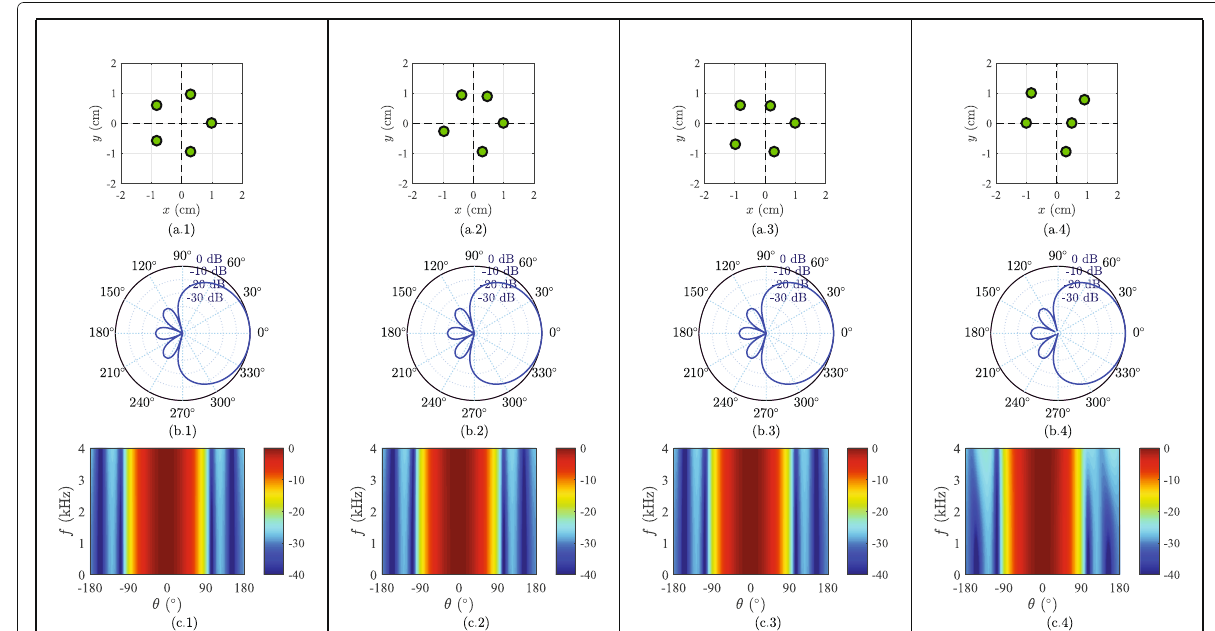
Fig. 5 Array geometries and the corresponding beampatterns of a second-order differential beamformer: a array geometry, b beampatterns at f = 500 Hz, and c broadband beampattern versus frequency